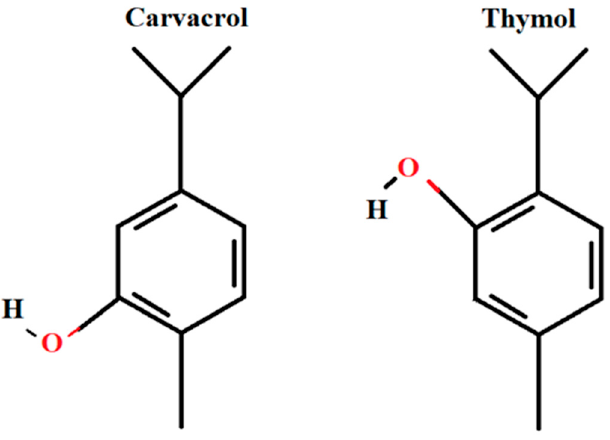
Figure 1. Chemical structure of carvacrol and thymol.